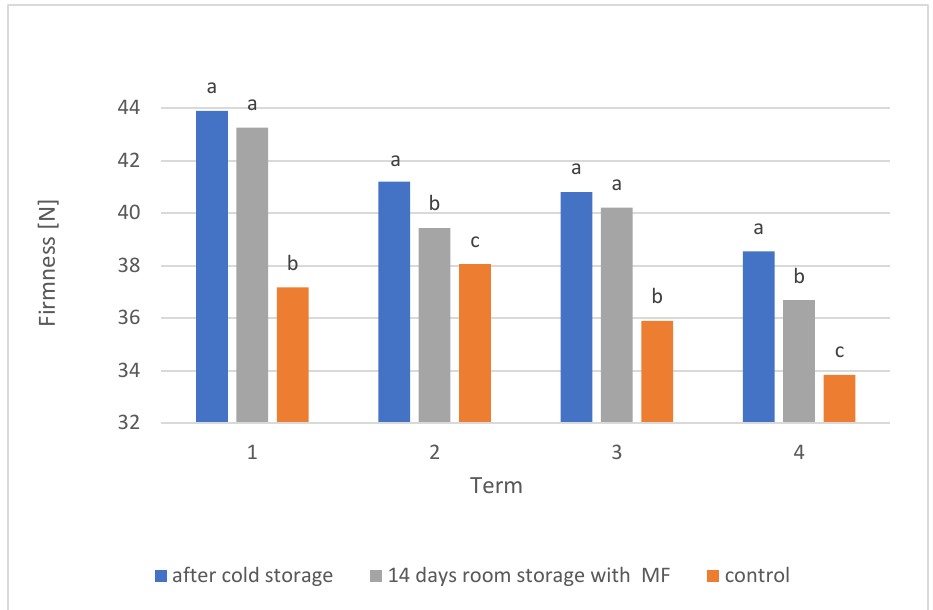
Figure 3. Effects of MF on the firmness of Idared apples after 120 days of cold storage. For each experiment, apples were stored in room conditions for 14 days. Statistically significant differences are marked by different letters. Differences between average values that are marked with the same letters (a,b) are not statistically significant. The data were analysed separately for each